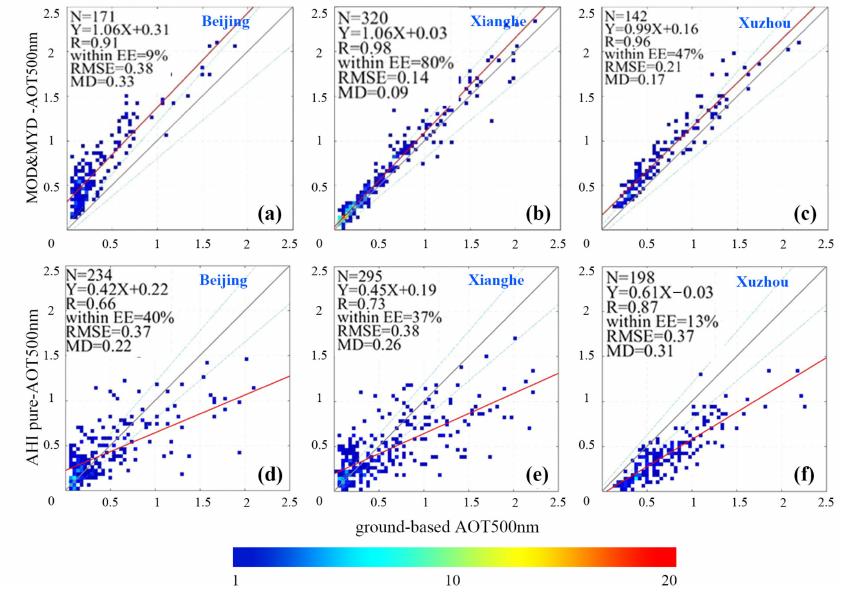
Figure 4. Scatterplots of the AOTs from di ff erent satellites against ground-based measurement at 500nm. The top row represents MODIS 3 km AOT products and the bottom row is the 5 km AOT pure of version 010 with the same spatial range at Beijing, Xianghe, and Xuzhou. The means in the figure represent the same elements as in Figure 3.